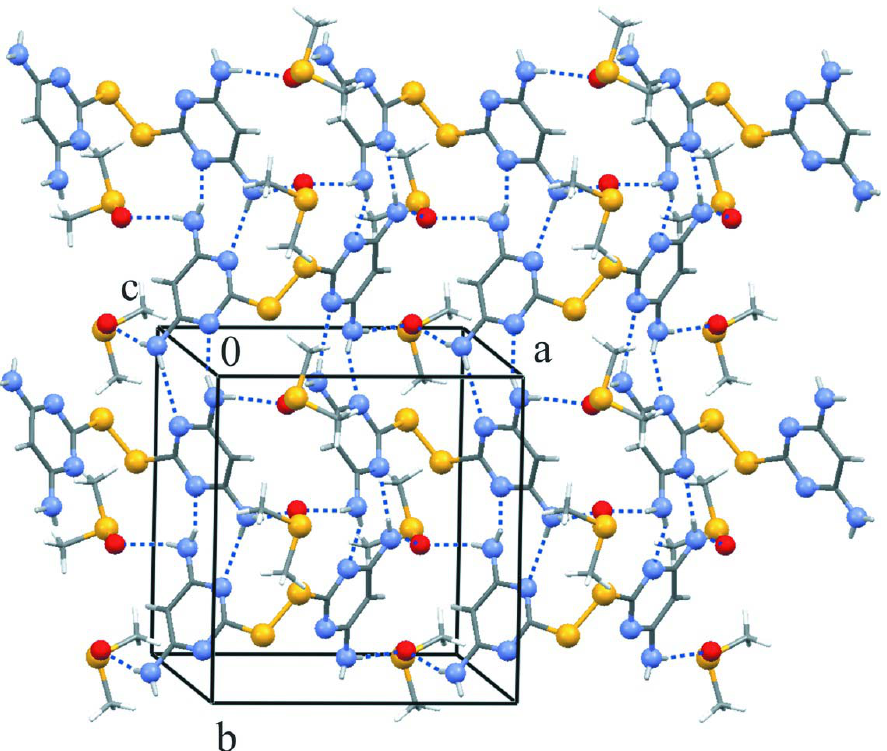
Figure 3 Hydrogen-bonded two-dimesional assembly of molecules in (I), parallel to the (001) plane. Hydrogen bonds are shown with dashed